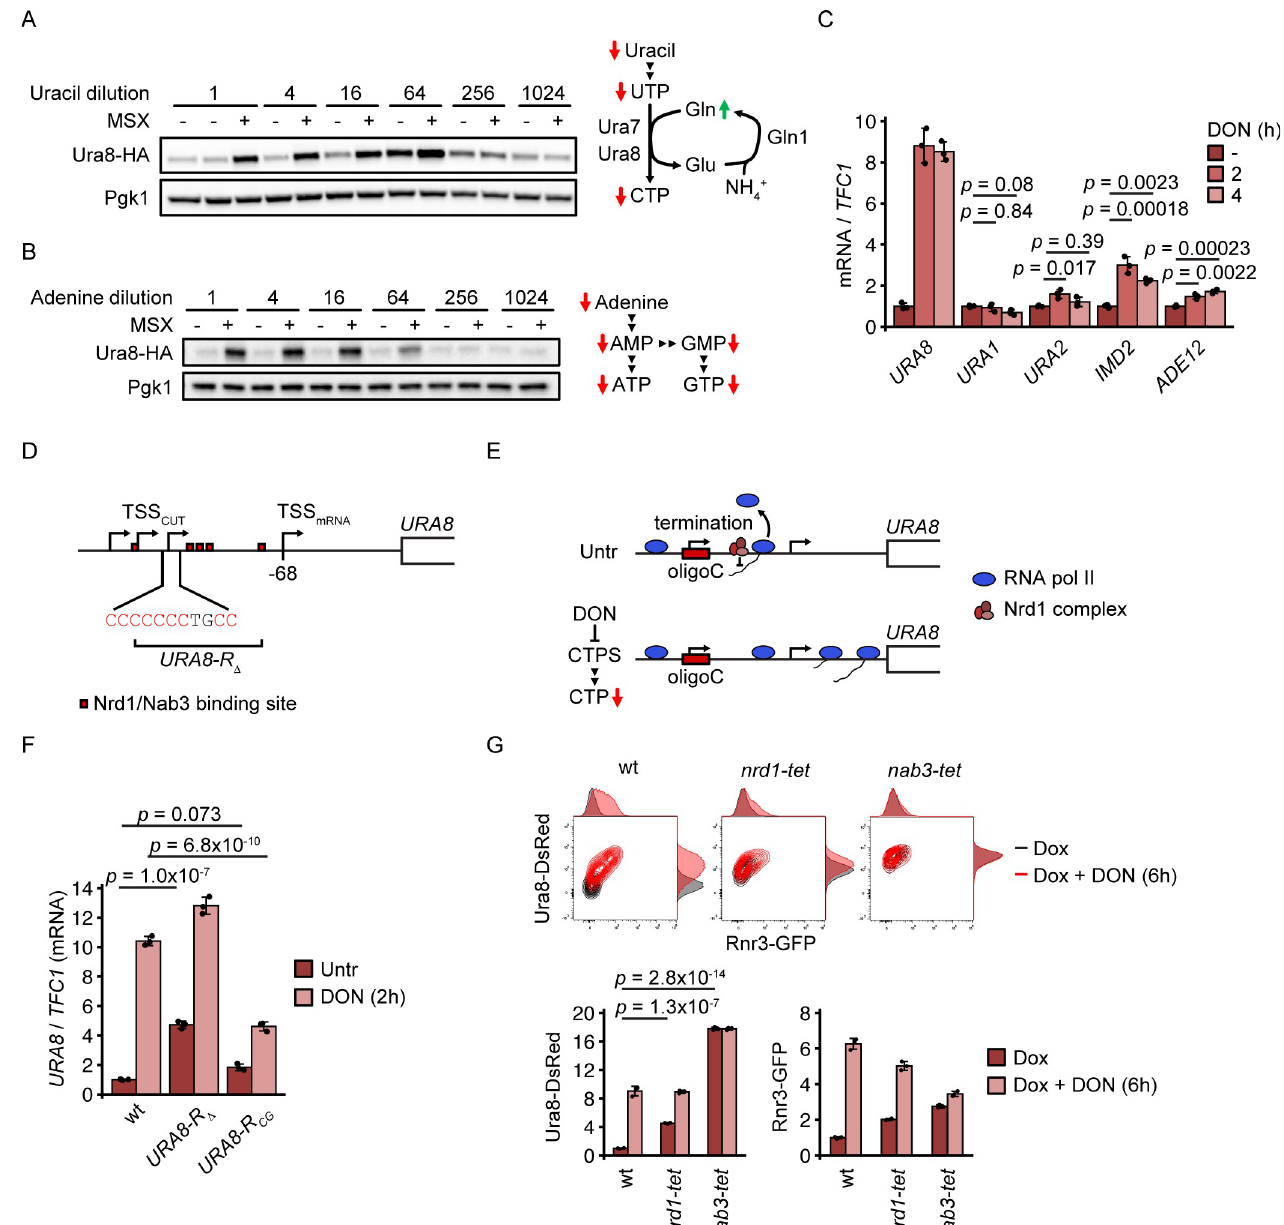
Fig 5. Regulation of the URA8 locus in response to glutamine analogs. (A, B) Cells expressing endogenous HA-tagged Ura8 were cultured in synthetic minimal medium, transferred to medium with the indicated dilutions of Uracil (A) or Adenine (B), with or without 15 μ M MSX, and fixed in TCA after 4h. Proteins were analyzed by Western blot. The adjacent schemes summarize the expected metabolite alterations induced by restriction of Uracil (A) or Adenine (B). (C) Wildtype cells grown in YPD medium were treated with 300 μ M DON for the indicated duration. Samples were collected to quantify the indicated mRNAs by RT-qPCR using TFC1 as reference (n = 3 independent replicate cultures). Significances were calculated with 1-way ANOVA ( p = 0.0119, p URA2 = 0.0194, p IMD2 = 0.000212, p ADE12 = 0.000265) with post hoc Tukey HSD test. The same samples as in Fig 1G were used, and the URA8 expression data from Fig 1G was included for quantitative comparison. (D) Schematic of the URA8 ORF upstream DNA region. Information on transcription start sites is included. Oligo-C tract and R box region modified in delitto perfetto mutants are indicated. The coding strand DNA sequence is represented. (E) Working model of URA8 regulation by transcription start site selection. Top panel, untreated cells: RNA polymerase II initiates transcription at C-containing start sites. The Nrd1 complex terminates transcription leading to CUT production and preventing the progression of RNA polymerase II into the URA8 ORF. Bottom panel: Low CTP levels suppress transcription initiation at C-containing start sites. RNA polymerase II initiates transcription downstream of Nrd1 complex binding sites and transcribes the URA8 ORF. (F) Delitto perfetto mutants with URA8 R box deletion ( URA8-R Δ ) or C-to-G substitutions in the URA8 upstream oligo-C tract shown in (D) ( URA8-R CG ) were arrested in G1 phase with α -factor and released into YPD with or without 300 μ M DON for 2h. Samples were collected to quantify URA8 mRNA by RT-qPCR using TFC1 as reference (n = 3 independent delitto perfetto clones). Significances were